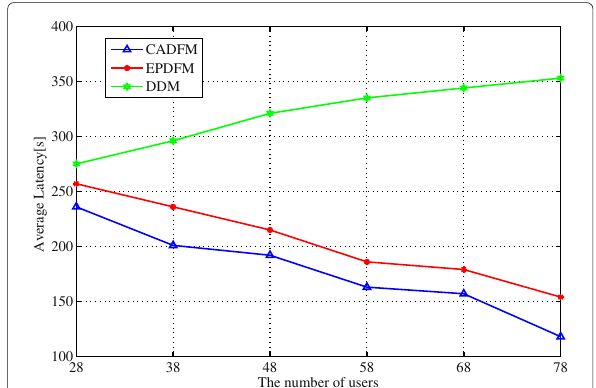
of all three mechanisms are reduced because of the increased number of users and user encounter probabil- ity. For DDM, the difficulty of reaching the receiving user is increased due to the growing number of users; thus, the average delivery delay is the highest. As shown in Fig. 5, the average delivery delay of CADFM is the lowest,